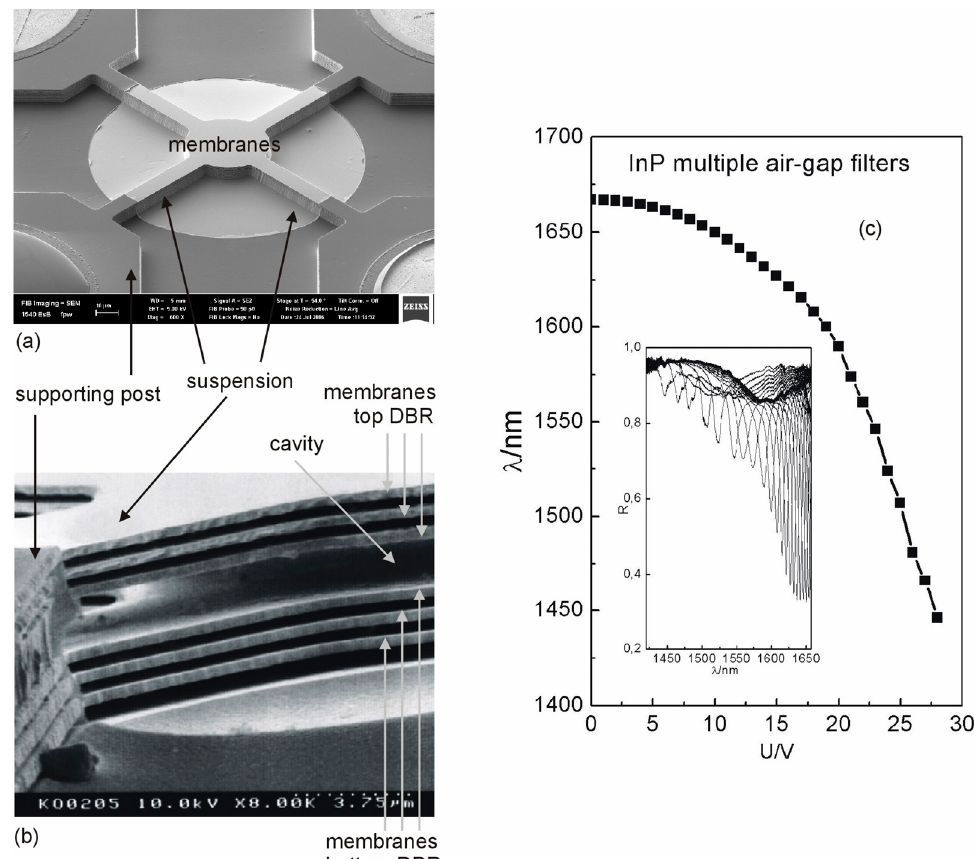
Figure 15. ( a ) SEM image in tilted top view on an InP multiple air-gap MEMS tunable FP filter with InP/InGaAs supporting posts with contacts on top; ( b ) SEM image in tilted side view, enabling a look through the central airgap between the suspensions; ( c ) Tuning characteristic showing the filter peak wavelength as a function of the actuation voltage. A selection of experimental reflection spectra R ( λ ) is displayed in the inset. Various spectra are shown for different actuation voltages U . Reprinted with permission from ref. [11]. Copyright 2021 MDPI.